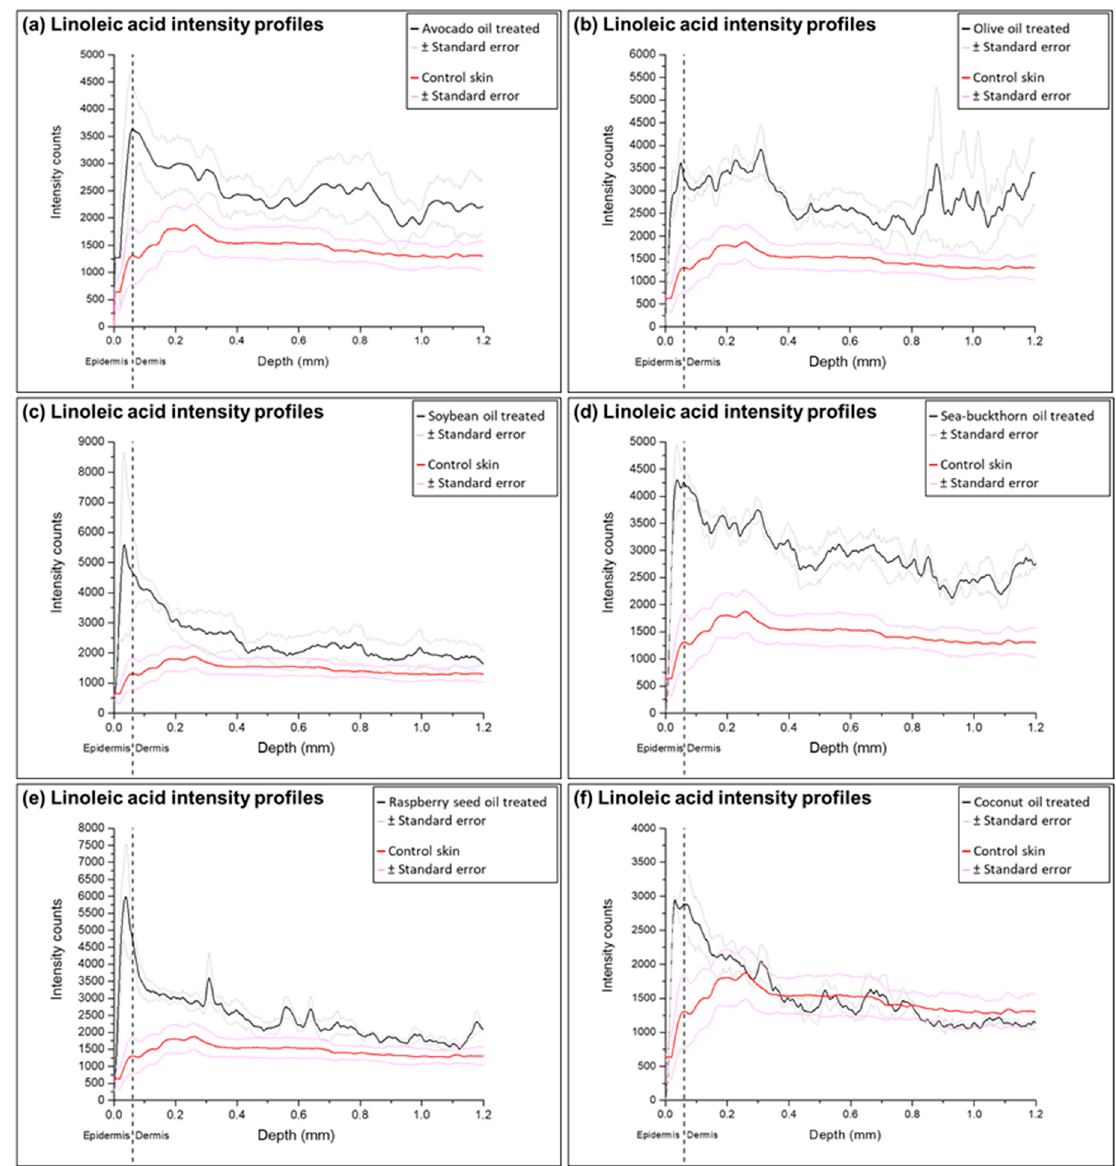
Figure 4. Ion intensity profiles for linoleic acid detected in samples treated with natural oils and compared to the intensity profiles of the control: ( a ) avocado oil; ( b ) olive oil; ( c ) soybean oil; ( d ) sea-buckthorn pulp oil; ( e ) raspberry seed oil; ( f ) coconut oil. The intensity profile of treated samples is shown as a solid black line, and solid red line indicates the control. Similar fluctuations are visible in all FA profiles.